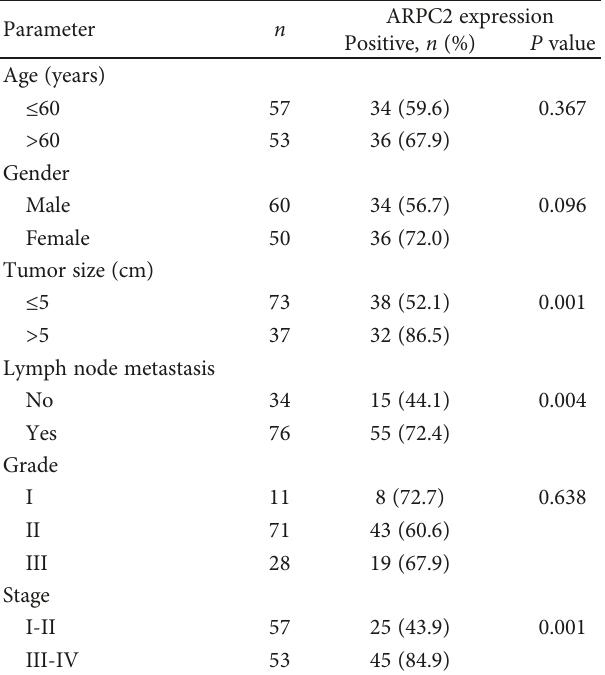
Figure 4: Relapse-free and overall survival curves strati fi ed by ARPC2 expression. (a) Expression of ARPC2 protein in normal gastric tissues and gastric cancer tissues was detected using immunohistochemistry method, and representative pictures are shown. Magni fi cation: 200. (b) Gastric cancer patients with positive expression of ARPC2 were associated with worse relapse-free survival and overall survival. Table 2: Correlation of ARPC2 expression with clinicopathological parameters from gastric cancer